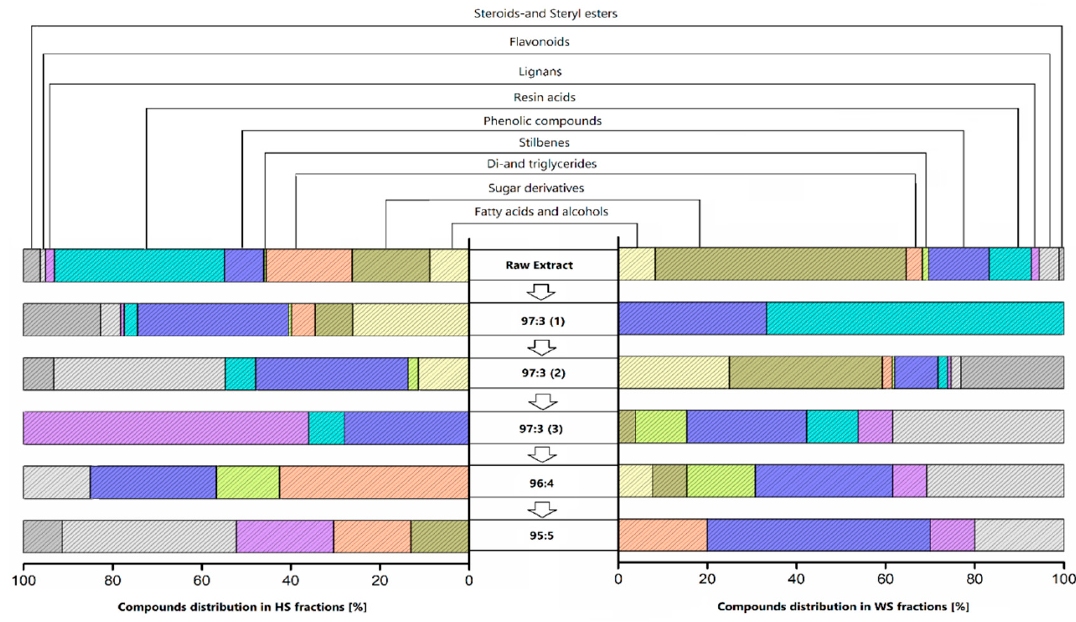
Figure 4. Groups distribution of crude extract and their fractions after separation by flash chromatography.